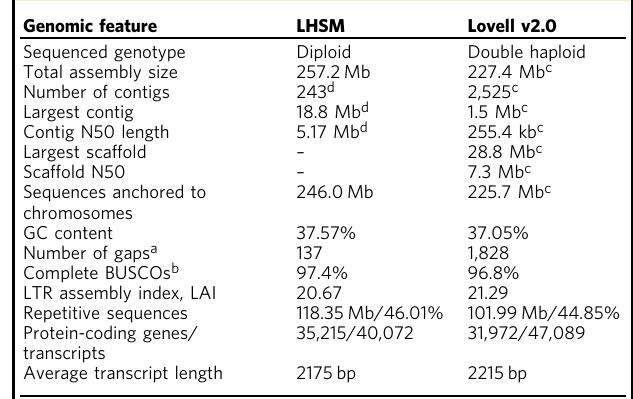
Table 1 Summary statistics for the LHSM genome assembly in comparison with the Lovell v2.0 reference